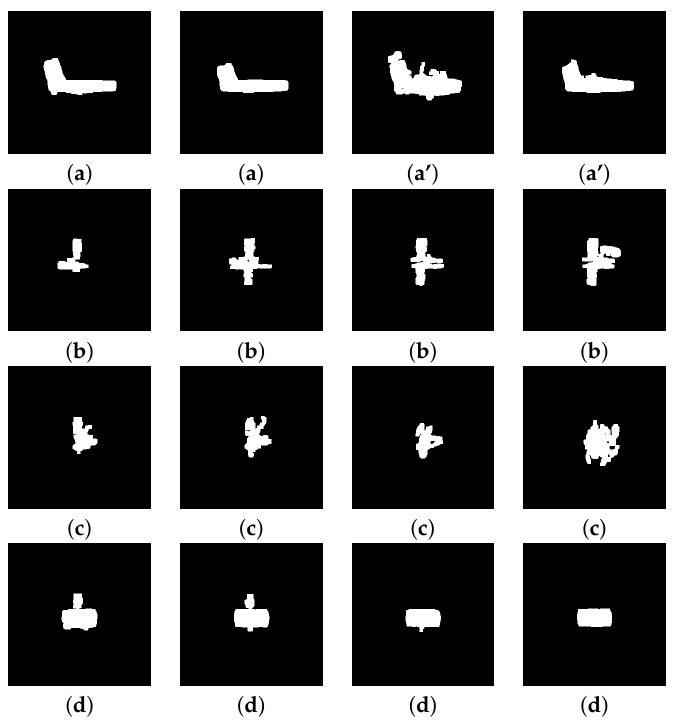
Figure 14. Segmentation of ‘H + V’ images, at frequency 94 GHz, with threshold parameter 0.59 and size 2 for the structuring element: ( a ) concealed gun, ( b ) knife, ( c ) keys, ( d )